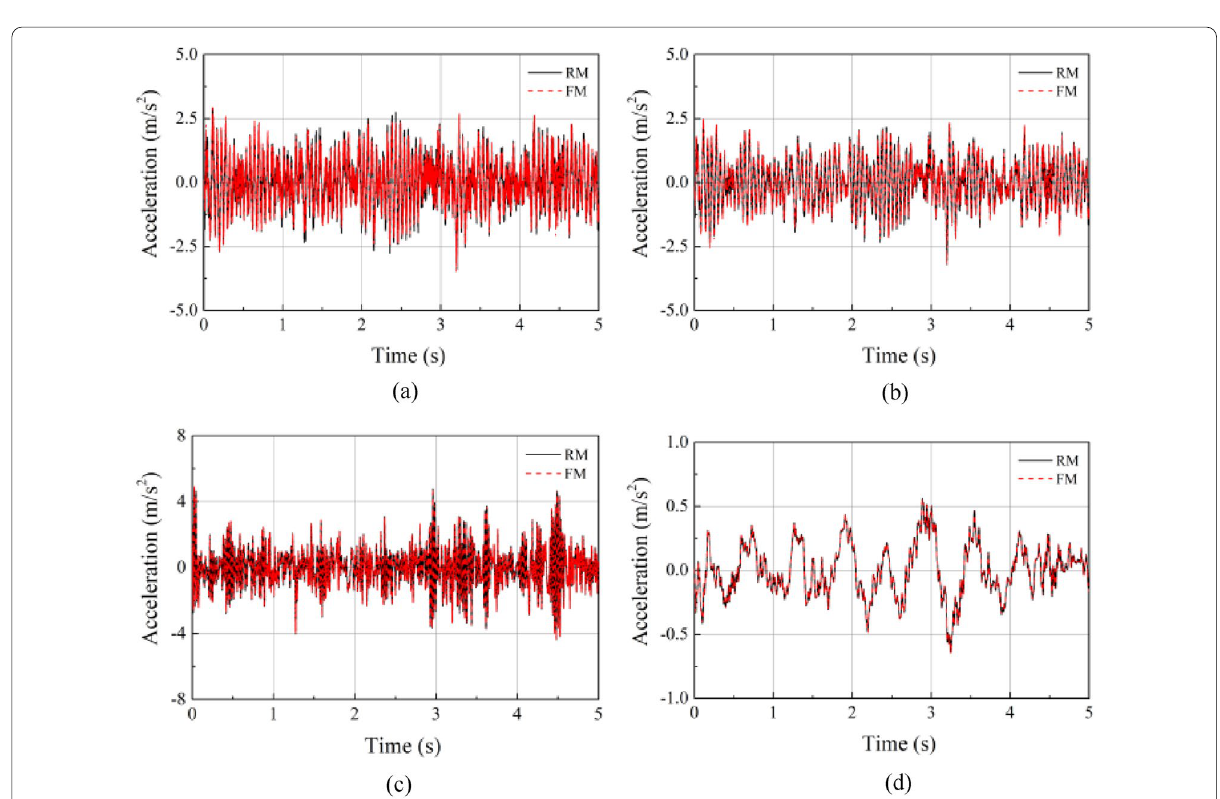
Figure 9 Vertical vibration responses of the vehicle system: a rotor, b motor, c wheelset, and d